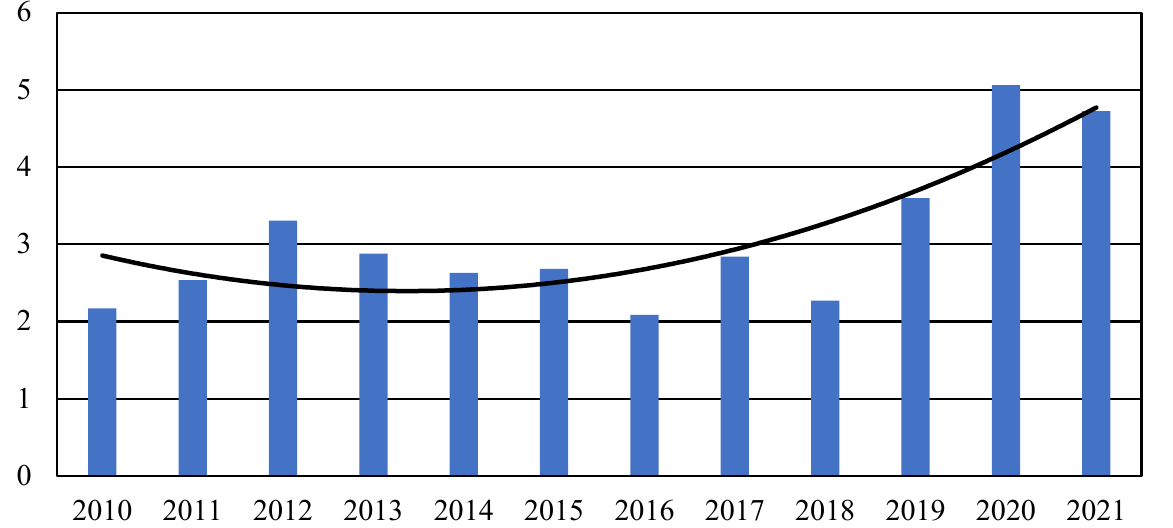
Figure 7. The potential of biodiesel production from oil crop waste (bran) in the counties (t). About 5601 t. of diesel biofuel (maximal amount in 2020), which has a low cost due to own production as compared with a traditional fuel, can be obtained from oil crop waste (bran). The dynamics of the potential of diesel fuel production from oil ‐ crop waste ( P 2 ) can be described using Equation (5). The most reliable forecast of the assessment of the pro ‐ duction potential of diesel biofuel from oil ‐ crop waste in Lithuania is given when using a polynomial second ‐ order function (probability of the approximation R 2 = 0.64):